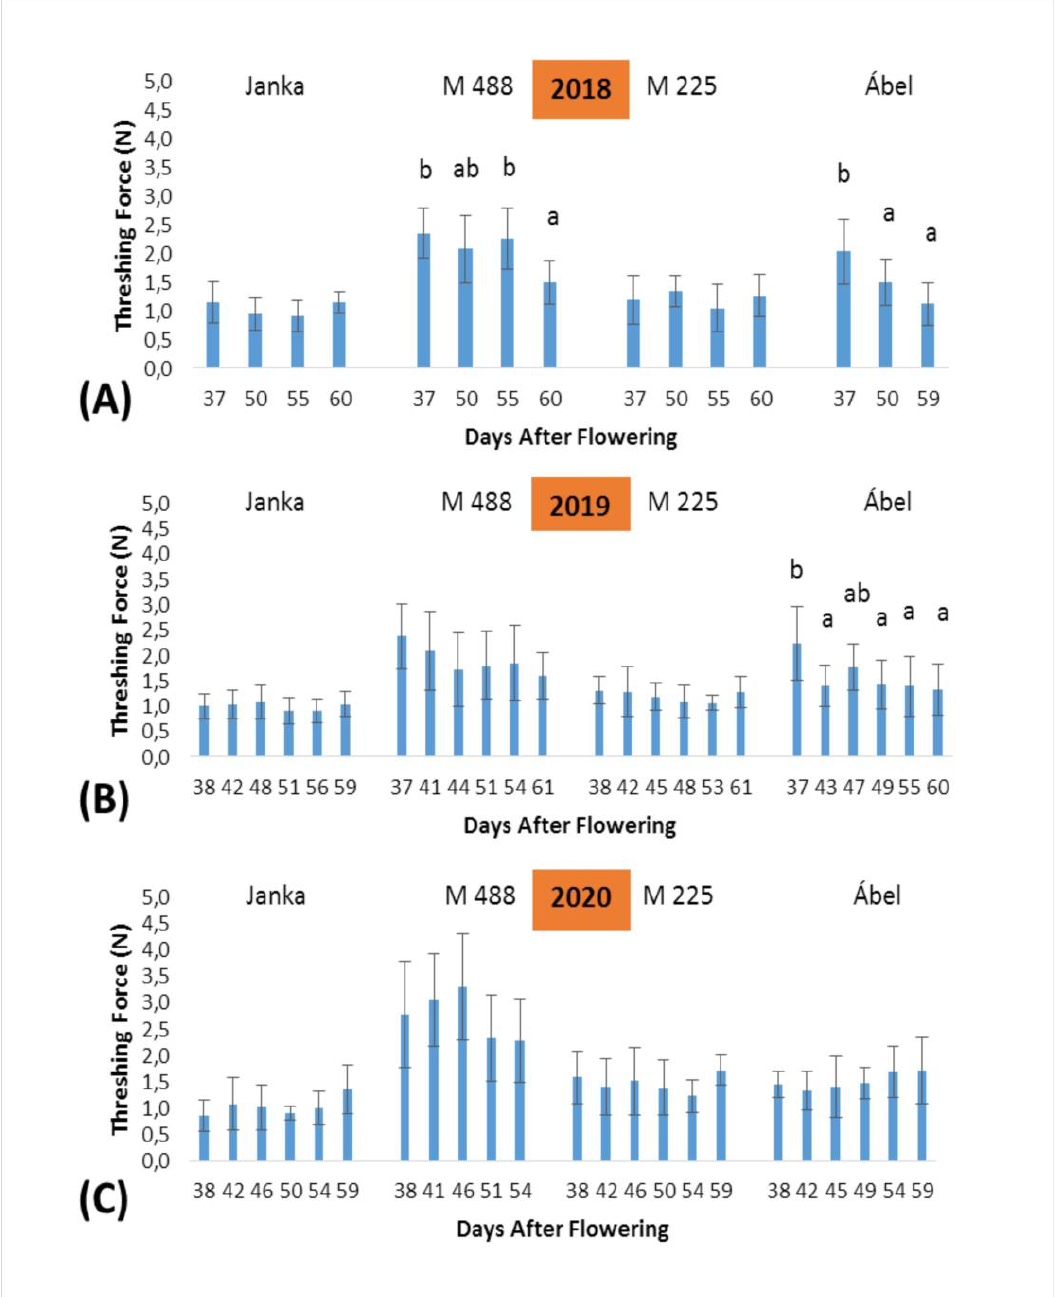
Figure 3. Mean threshing force in Newton (TF, N) ( n = 10, 12, 12, in 2018—( A ), 2019—( B ) and 2020—( C ), respectively) values in different measurement times during the ripening of four rice varieties. The different letters mean significant differences among the measurement times in each variety, respectively at the probability of level 0.05. (No letters are written where there are no significant differences among measurement